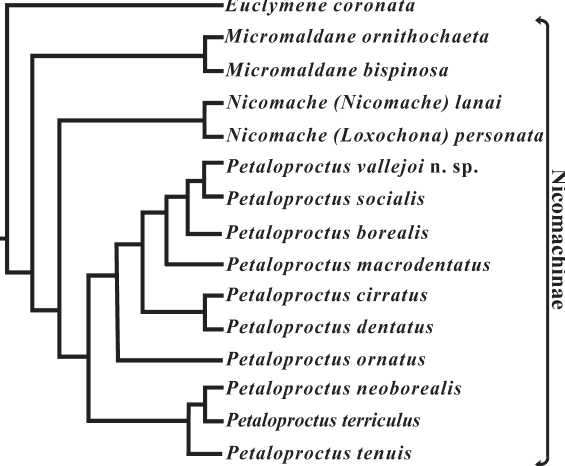
Fig . 3. – Most resolved phylogeny of nicomachinae (tree length = 37 steps, iC = 0.89, ri = Table 1. – Character matrix for phylogenetic analysis of Petaloproctus . (0, plesiomorphic state; 1-2, successively apomorphic states). taxa